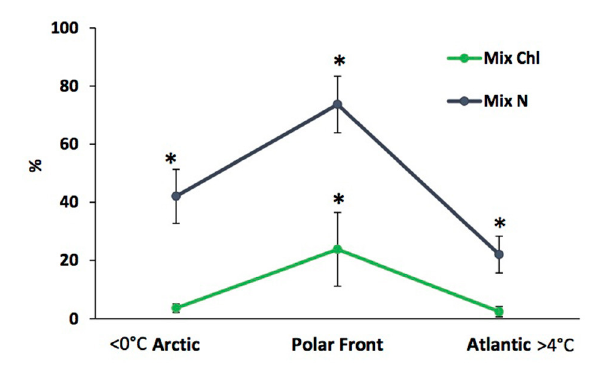
FIGURE 2 | Relative abundance and contribution to total chlorophyll a of mixotrophic ciliates in the deep chlorophyll layer along the latitudinal gradient in the Barents Sea (modified from Franzè and Lavrentyev, 2017). Vertical bars,standard deviation; asterisks denote significant difference ( p < 0.05) based on ANOVA and Fisher LSD test. Mix N, relative abundance of mixotrophic ciliates; Mix Chl, estimated contribution of mixotrophic ciliates to total chlorophyll